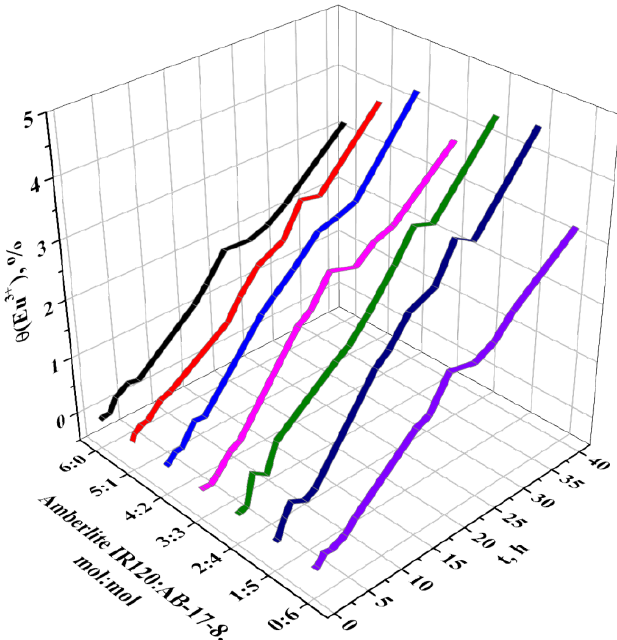
Figure 6. Polymer chain binding degree in dependence from molar ratios and time.